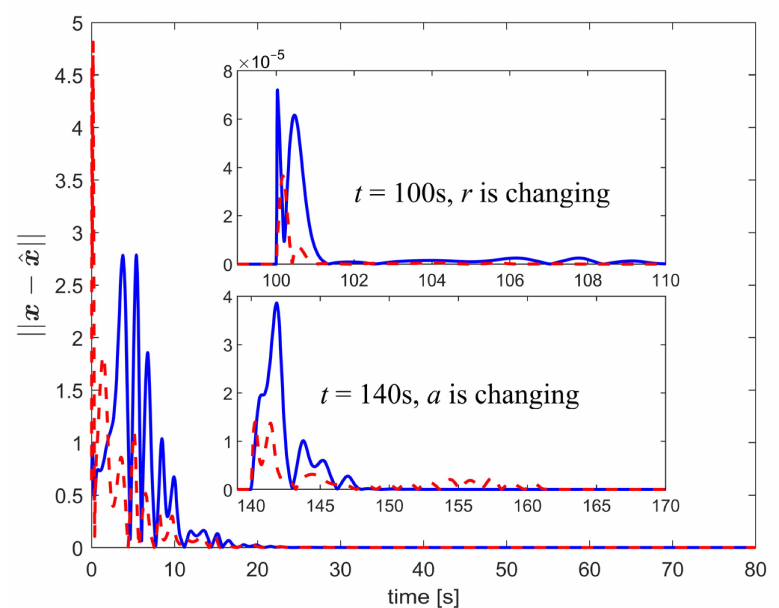
Figure 5. Norm of (cid:107) x − ˆ x (cid:107) , design parameters: k T = [ 15 75 125 ] , providing triple eigenvalue of A 0 at − 5, Γ = diag ( 800;1600 ) , solid line; design parameters: k T = [ 30 300 1000 ] , providing triple eigenvalue of A 0 at − 10, Γ = diag ( 80 000;160 000 ) , dashed line.